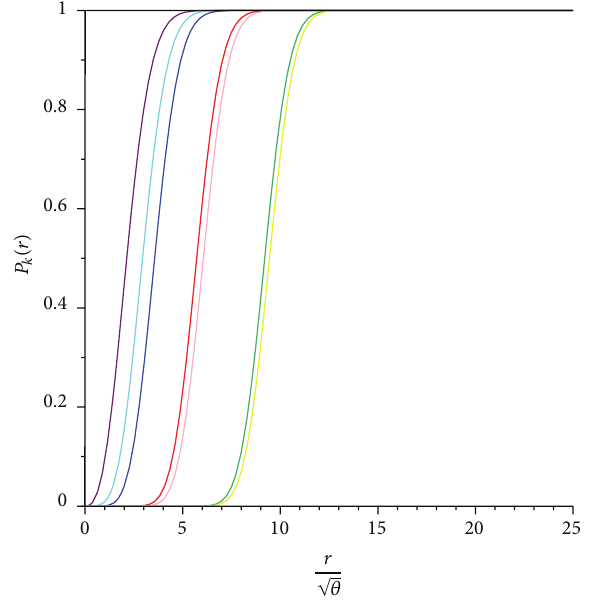
Figure 1: Plot of the function 𝑃 𝑘 (𝑟) as a function of 𝑟/√𝜃 for 𝑘 = 0 (purple), 𝑘 = 1 (cyan), 𝑘 = 2 (blue), 𝑘 = 7 (red), 𝑘 = 8 (pink), 𝑘 = 20 (green), and 𝑘 = 21 (yellow). For comparison, the Heaviside function is plotted in black.